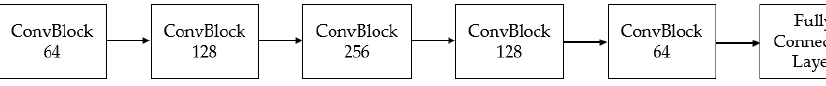
Figure 5. Network structure diagram.